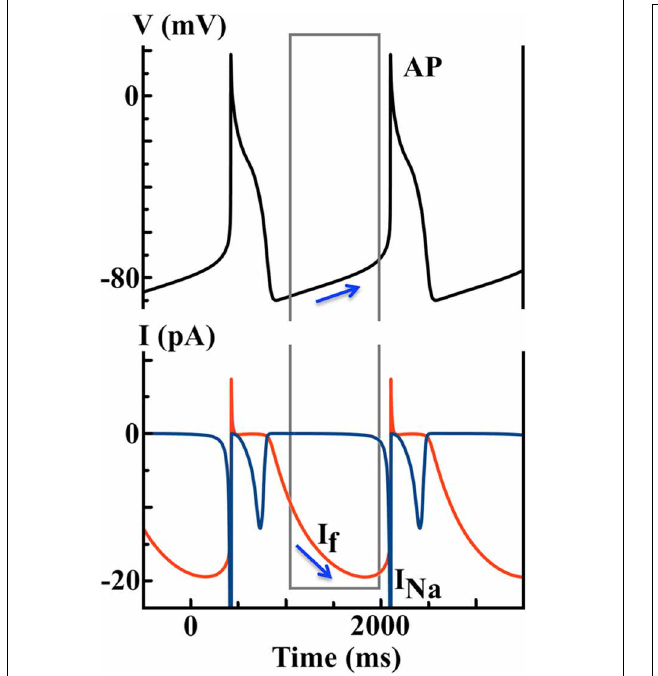
FIGURE 3 | Simulated AP and ionic currents using the DiFrancesco Noble (DN) 1985 Purkinje cell model to illustrate the I f hypothesis. Blue arrows indicate that the hyperpolarization-activated I f during the diastolic depolarization (DD) finally triggers a spontaneous AP.